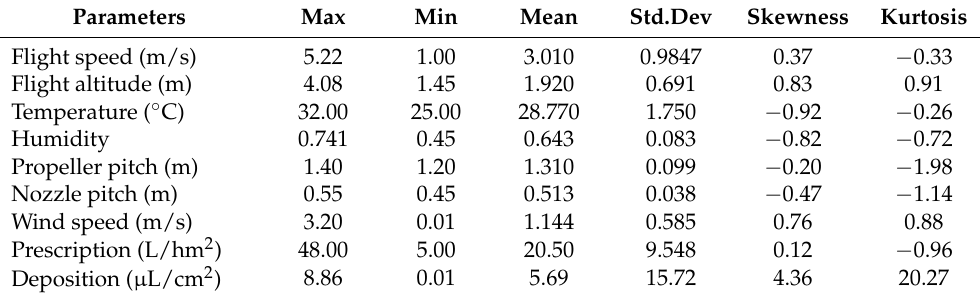
Table 2. Statistical properties of sample